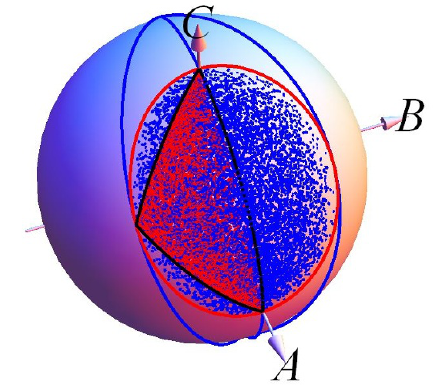
Figure 1 . Allowed values of normalized ( A; B; C ) assuming Dirac (blue points) or Majorana (red points) neutrinos. The blue curves represents Rosen’s original results ( R (cid:26) = 0, 2 and 4 from left to right, respectively) while the actually allowed ranges are smaller, surrounded by the red curves (for Dirac neutrinos) or black curves (for Majorana